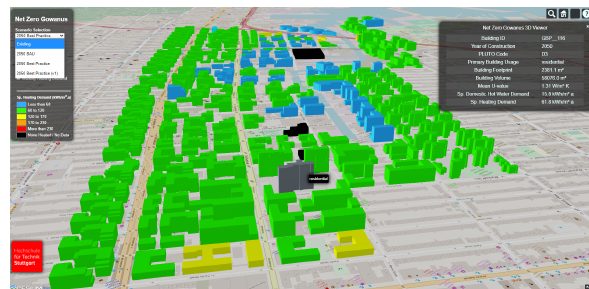
Figure 16. A proposed data exchange workflow between Urbanica and SimStadt